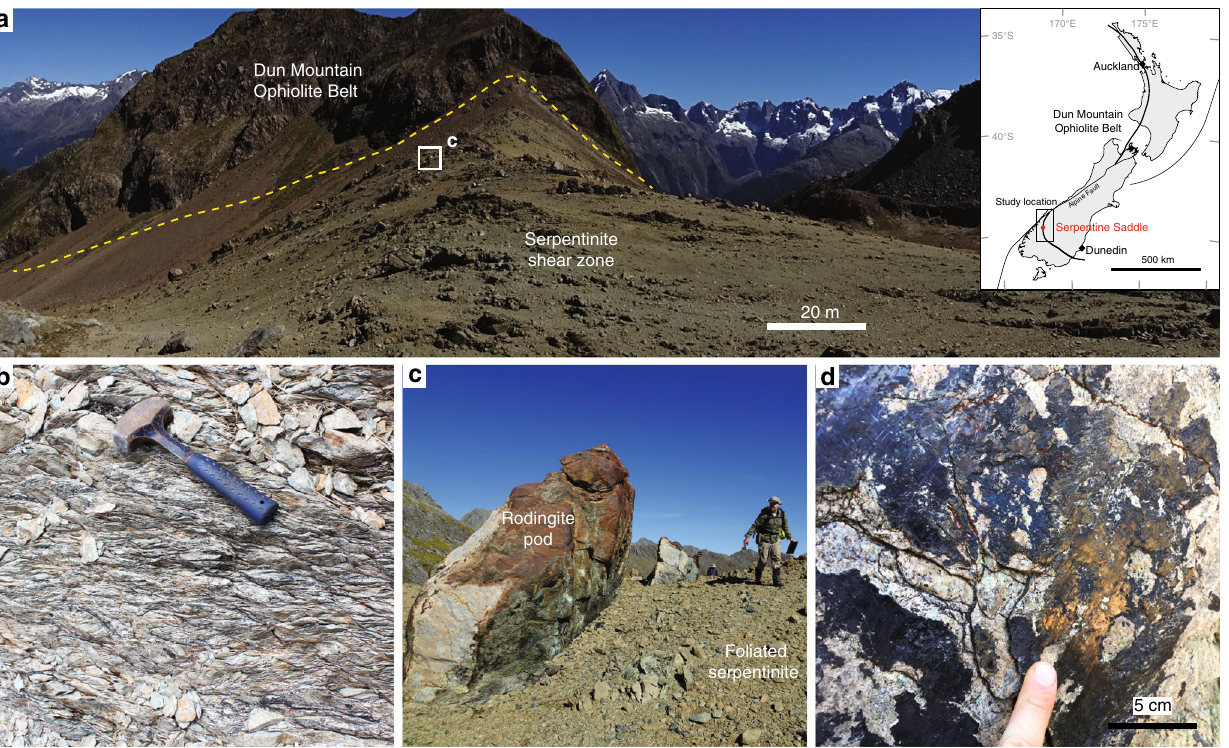
Fig. 1 The Livingstone Fault serpentinite shear zone. a Overview of a ~400m-wide section of the foliated serpentinite shear zone exposed at Serpentine Saddle ( − 44.65149, 168.16577). The inset shows the segment of the Livingstone Fault studied in this work and the speci fi c fi eld location from which the photo in part ( a ) was taken. b Foliated serpentinite with a pervasive anastomosing fabric. Each lens-shaped domain of serpentinite is coated by fi brous chrysotile. c Pod of rodingite surrounded by foliated serpentinite. d Striated and polished fault surface coated by a 300 µ m-thick layer of